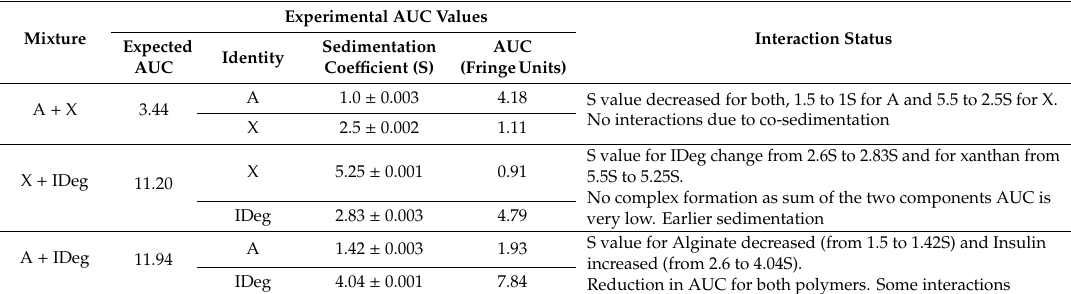
Table 2. Sedimentation coe ffi cient for two component system of Alginate, Xanthan with IDeg at pH 7.0, 50 mM PBS at 4 ◦ C. Expected values of area under curve for the two-component system are also given below. Any value below this means stable complex formation. ± values represent SD.